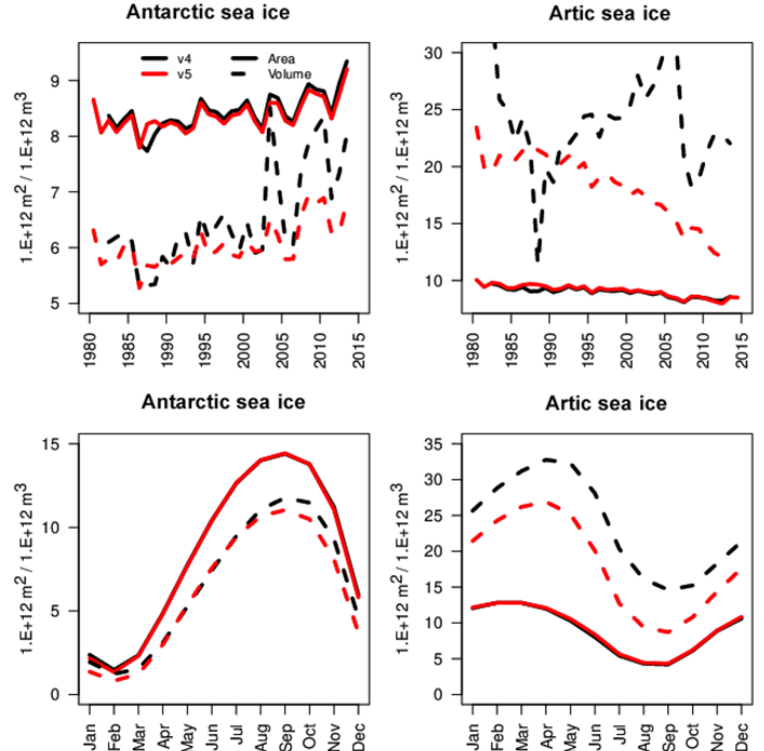
Figure 12. Antarctic (left panels) and Arctic (right panels) sea-ice area (solid lines) and volume (dashed lines) from C-GLORSv4 and v5. Top panels show yearly mean values and bottom panels show the 1982–2013 monthly